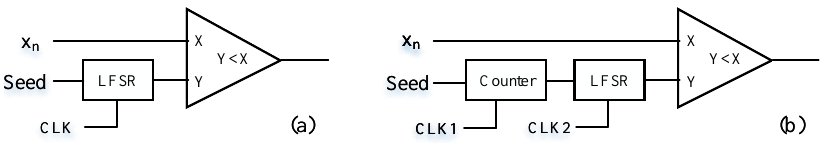
Figure 6. The circuit structure of SNG. ( a ) The conventional SNG; ( b ) The improved